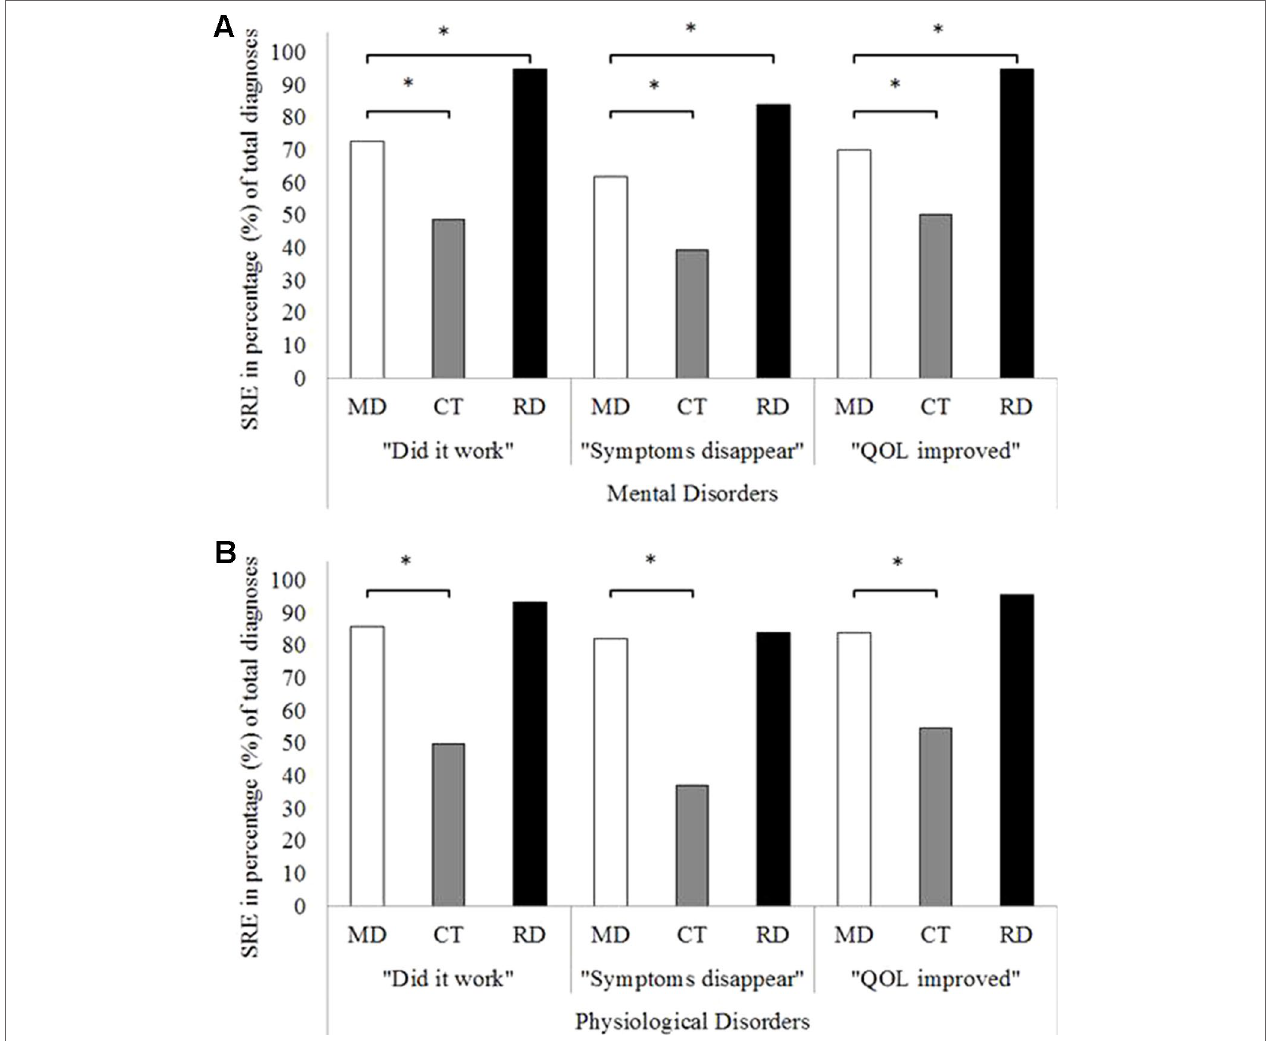
FIGURE 1 | Overall self-rated effectiveness of psychedelic microdoses, conventional treatment, and regular doses of a psychedelic on the three effectiveness questions for mental disorders (A) and for physiological disorders (B) . *Signifies statistically significant binary logistic regression p < 0.05. SRE, self-rated effectiveness; MD, microdose; CT, conventional treatment; RD, regular